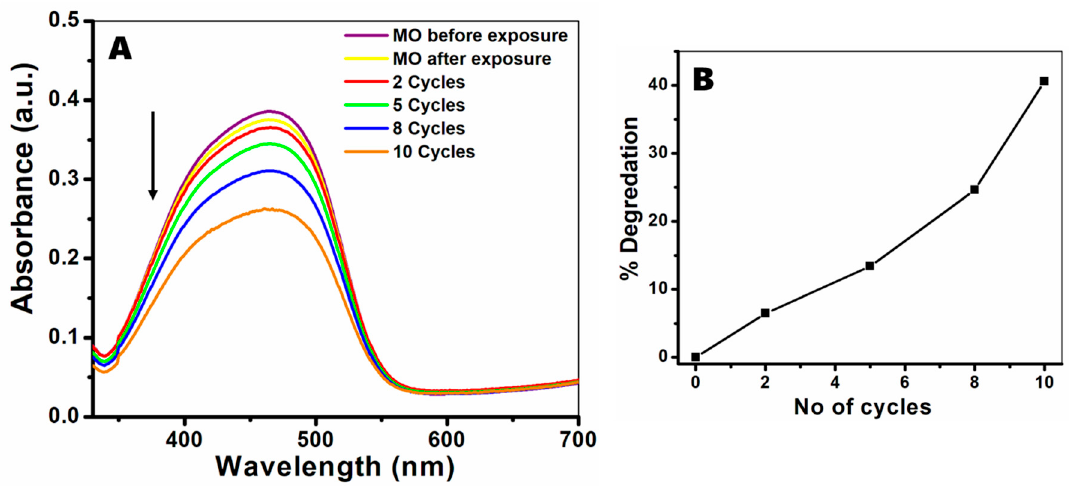
Figure 5. Methyl orange (MO) degradation assay. ( A ) Absorbance spectra of MO before and after exposure to UV radiation for 30 min (purple and yellow lines) and in the presence of powders after 2 (red), 5 (green), 8 (blue), and 10 (orange) cycles. ( B ) Degradation percentage of MO compared to the dye before UV exposure. Dye concentrations were calculated using the Beer–Lambert law.